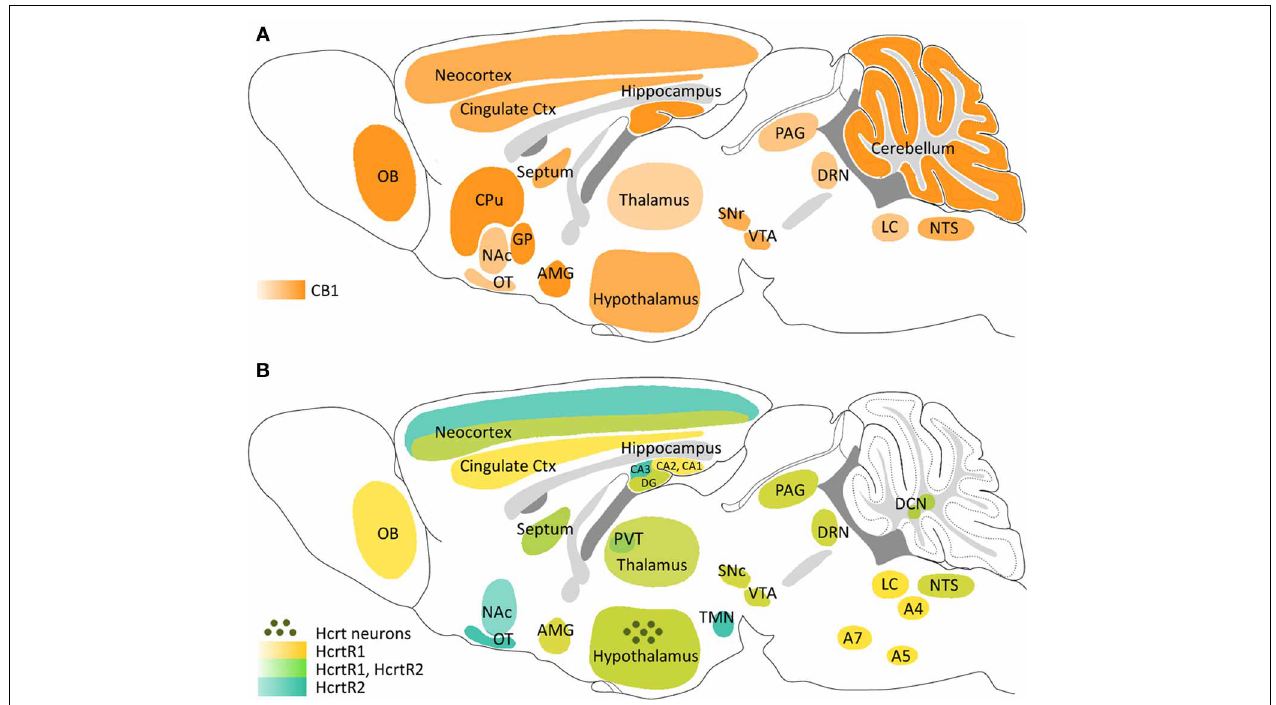
FIGURE 1 | Schematic representation of the main areas expressing CB1, HcrtR1 and HcrtR2 in the mouse brain and location of hypocretinergic neurons. (A) CB1 receptor distribution. (B) HcrtR1 and HcrtR2 distribution and localization of hypocretinergic neurons. A4, A5, A7, pons cell groups; AMG, amygdala; CPu, caudate putamen; Ctx, cortex; DCN, deep cerebellar nuclei; DRN, dorsal